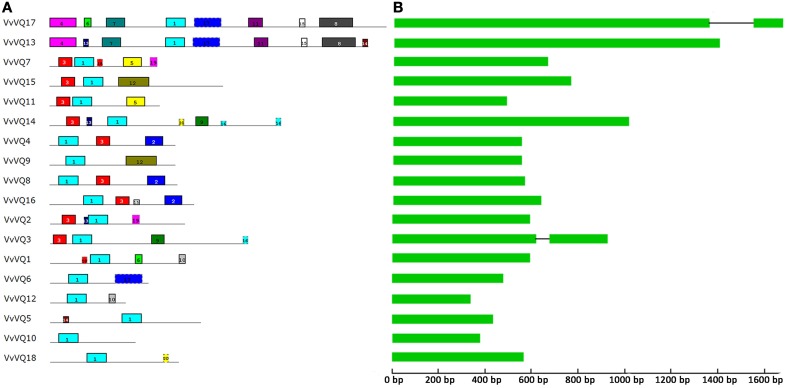
Structural analysis of grapevine VQ genes. (A) The motif composition within each VvVQ protein. The motifs, numbered 1–20, are displayed in different colored boxes. The sequence information for each motif is provided in Table 2. (B) Exon/intron structures of grapevine VQ genes. Exons were drawn to scale and are representred by boxes. Solid lines connecting two exons represent introns.